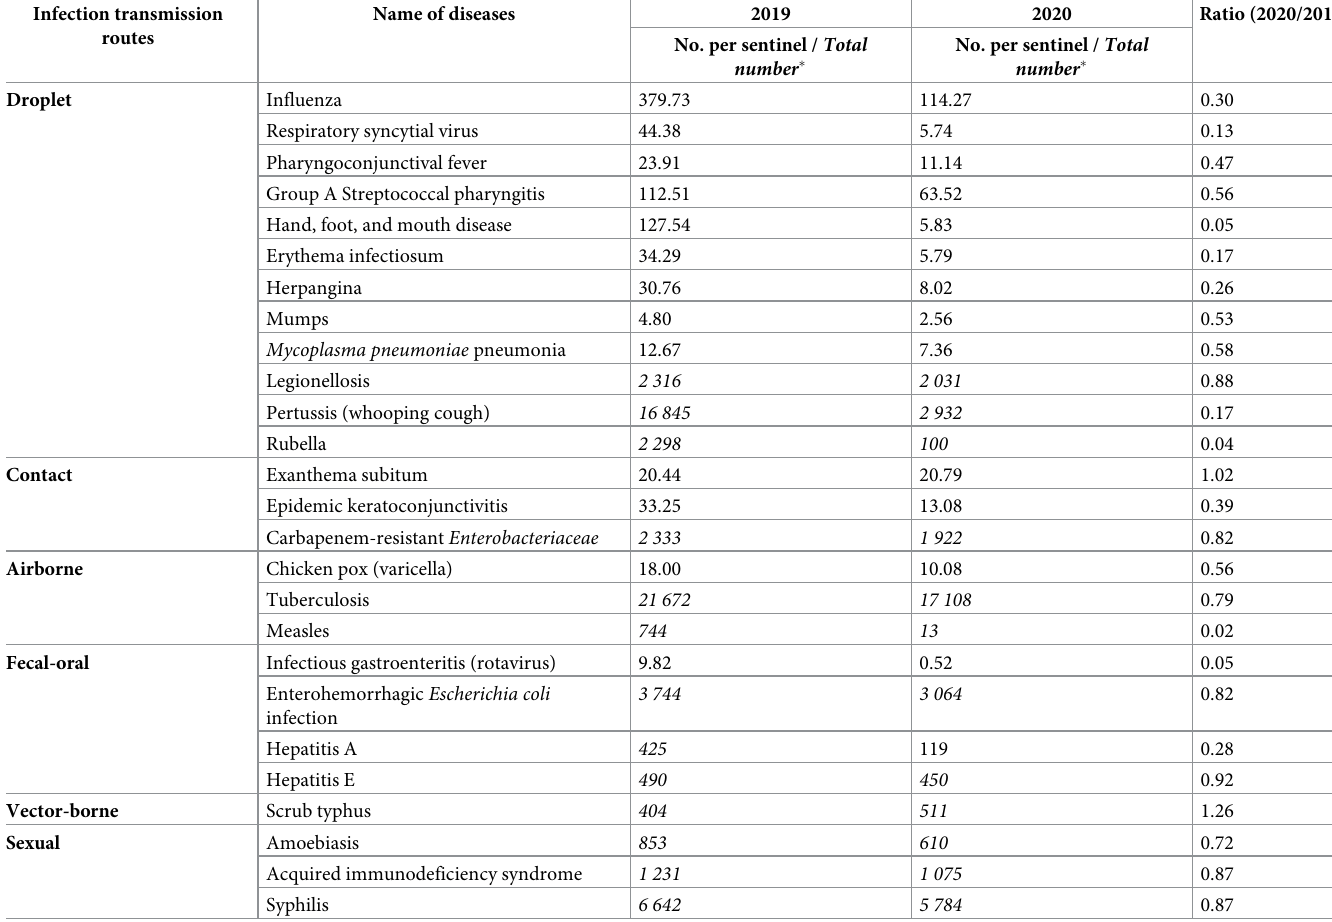
� The vertical bar represents the number of patients referred to one medical facility per week per selected time point, and italic figures show the total number by 100%